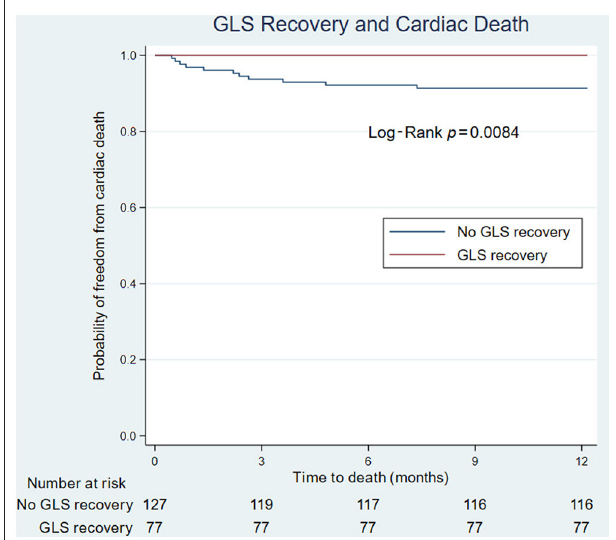
FIGURE 1 | Forest plot of echocardiographic variables that predict cardiac death or congestive heart failure hospitalizations. CHF, congestive heart failure; GLS, global longitudinal strain; LVEF, left ventricular ejection fraction; OR, odds ratio; SD, standard deviation; TAVR, transcatheter aortic valve replacement.